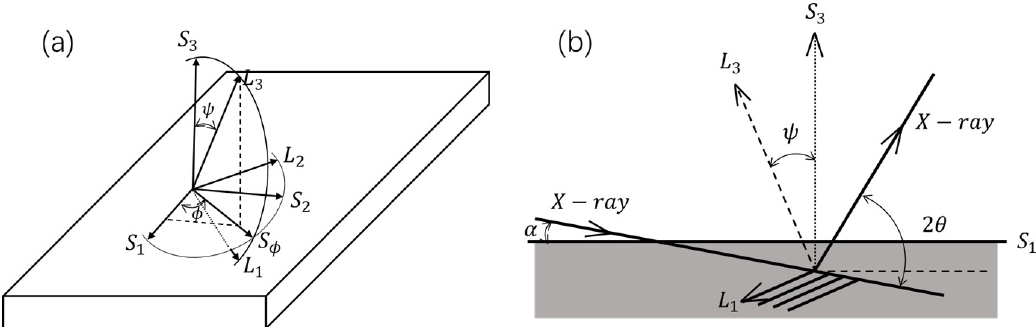
Figure 1. Definition of the laboratory coordinate system L i and sample coordinate system S i , and the angles ϕ and ψ ( a ). The asymmetric diffraction geometry of g − sin 2 ψ method ( b